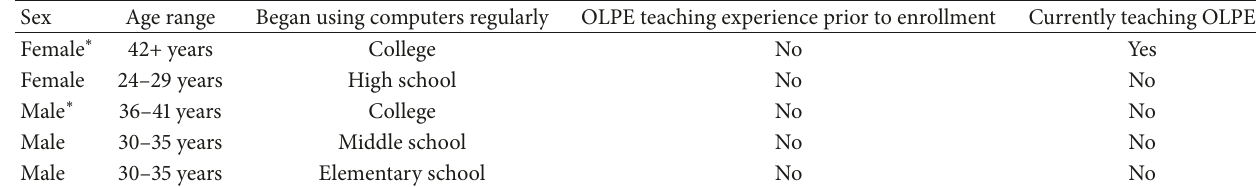
Table 1: Student participant demographics, survey